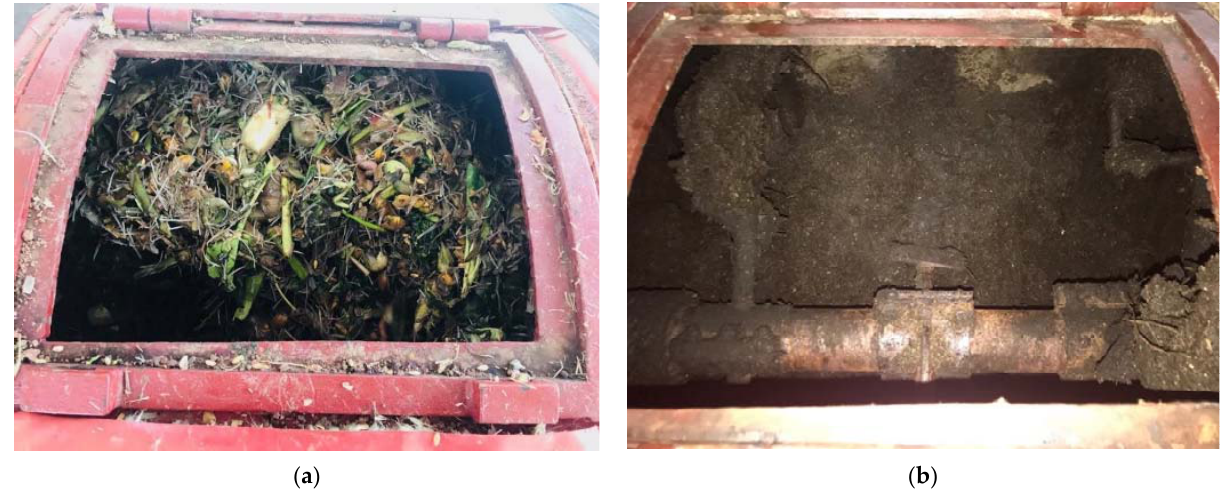
Figure 17. ( a ) The total of the waste weighted into the bioreactor. ( b ) After 20 h of heating, the temperature of the material was 90 °C. Table 5. Resulting temperature, moisture, and weight after heating for 20